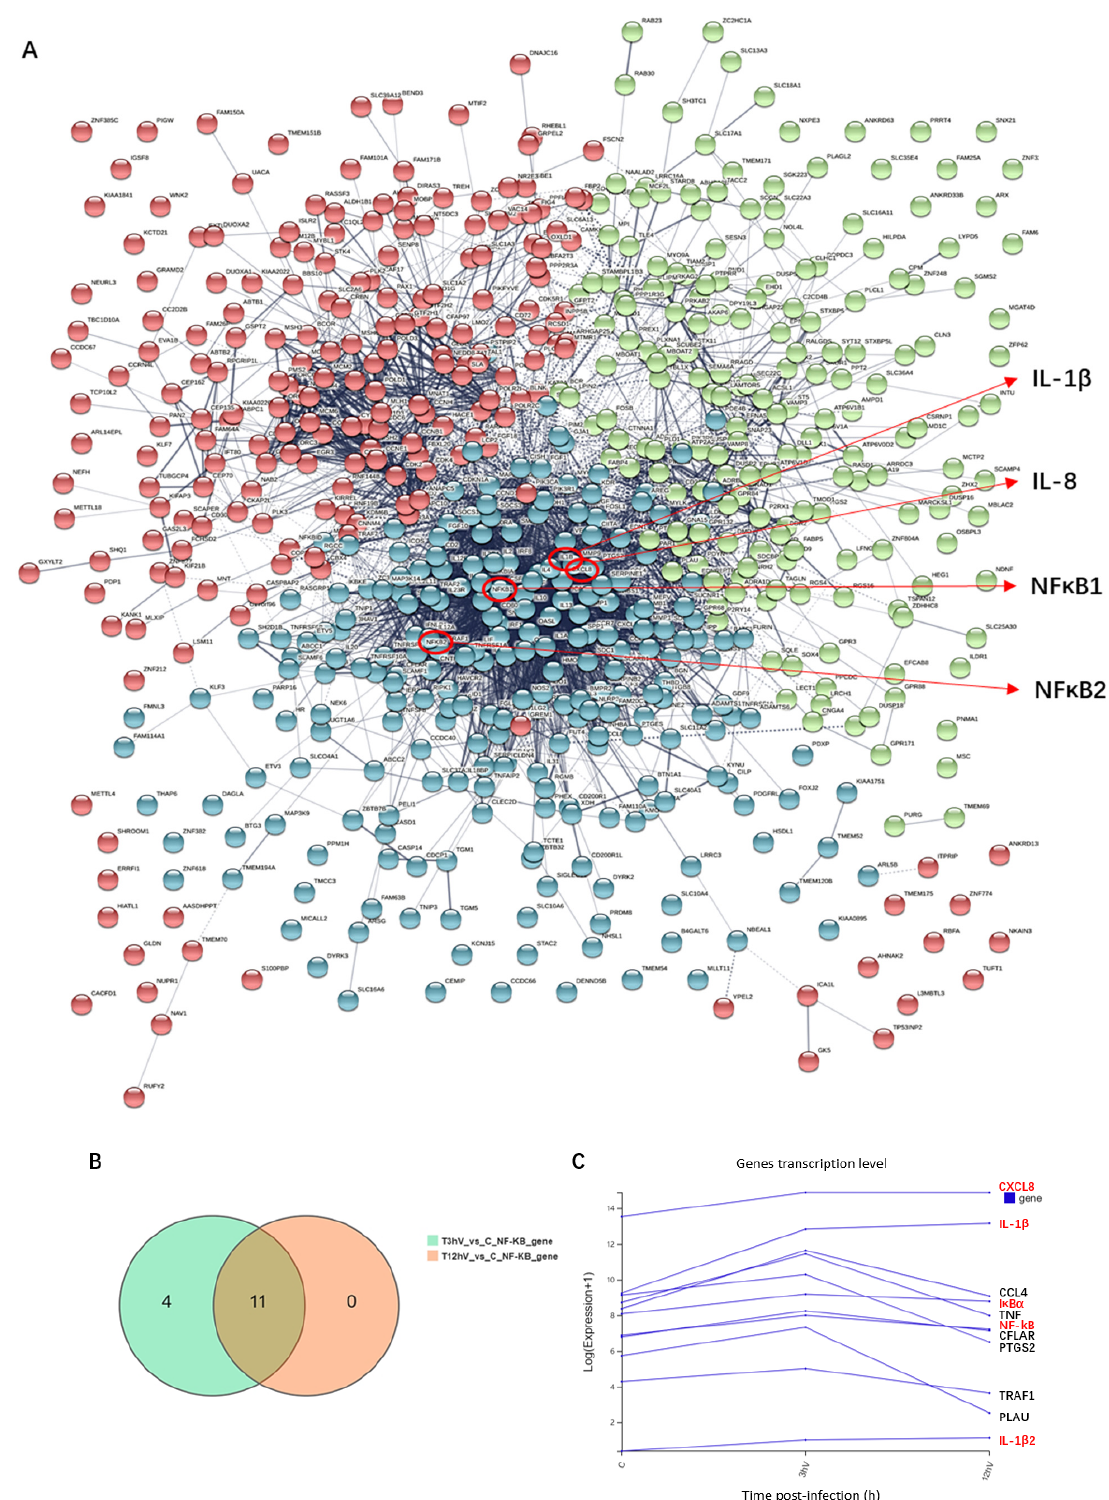
Figure 4. NF- κ B signaling pathway analysis after ASFV infection. ( A ) Analysis of protein network interaction of differential genes. ( B ) Venn diagram of differentially expressed genes in the NF- κ B signaling pathway after 3 h and 12 h infection with ASFV. ( C ) Variation in the trend of differentially expressed genes in the NF- κ B signaling pathway with an increase in ASFV infection duration.